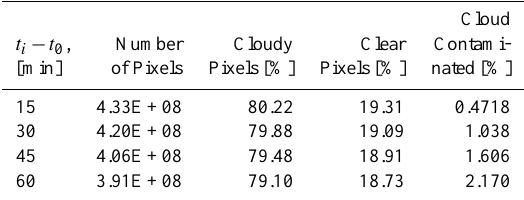
Table 1c. Statistics for Case C from MSG